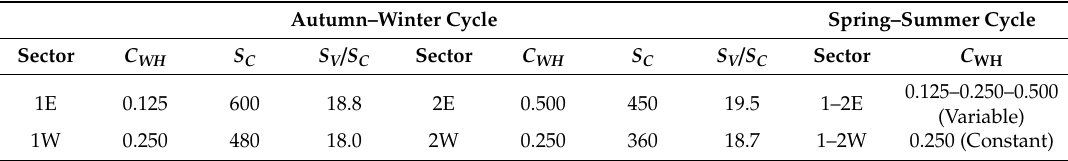
Table 1. Characteristics of sectors east (E) and west (W) of the two experimental greenhouses and di ff erent whitening concentration C WH (kg L − 1 ) applied in both crop cycles. Surface area of cultivated soil S C (m 2 ) and total ventilation surface area S V / S C